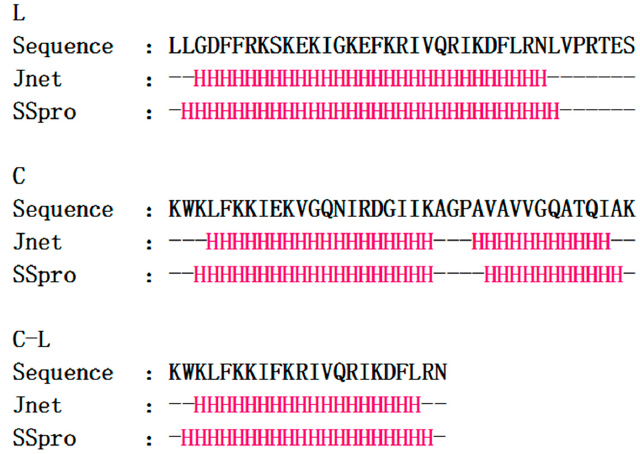
Figure 1. The secondary structure of hybrid peptides predicted by Jpred 4 and SSpro. “H” in red represents α -helical structure and “–” represents non α -helical structure.